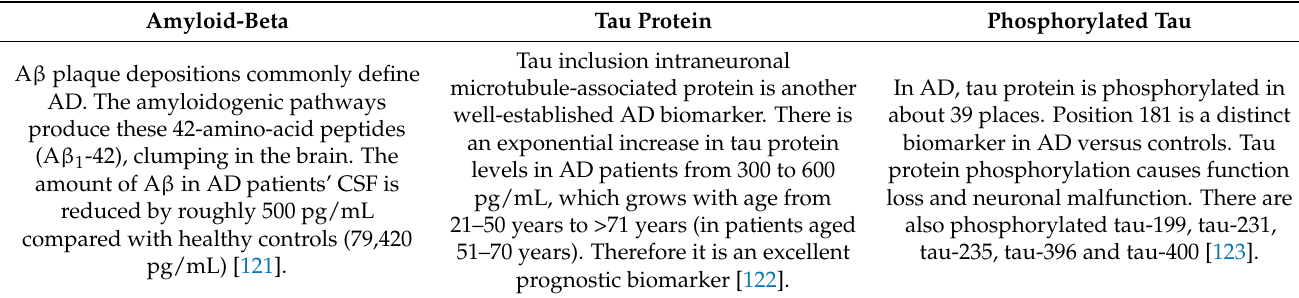
Table 1. Potential biomarkers with their